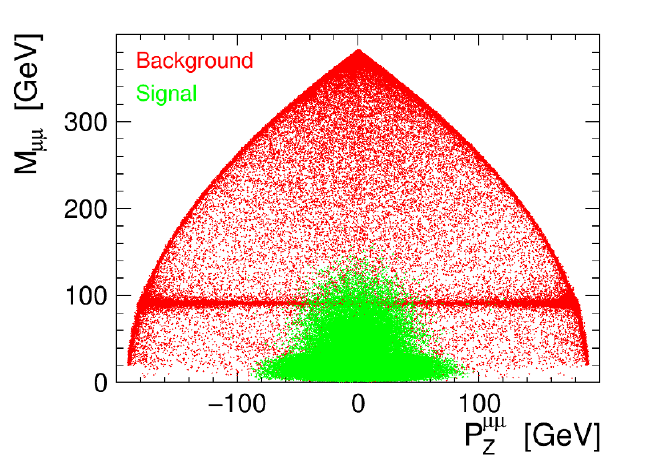
Figure 2 . Distribution of the lepton pair invariant mass, M (cid:22)(cid:22) , as a function of the lepton pair longitudinal momentum, P (cid:22)(cid:22) , for BP1 scenario (green points) and Standard Model background Z (red points). Same number of events were simulated for signal and background for centre-of-mass energy of 380 GeV, using CLIC luminosity